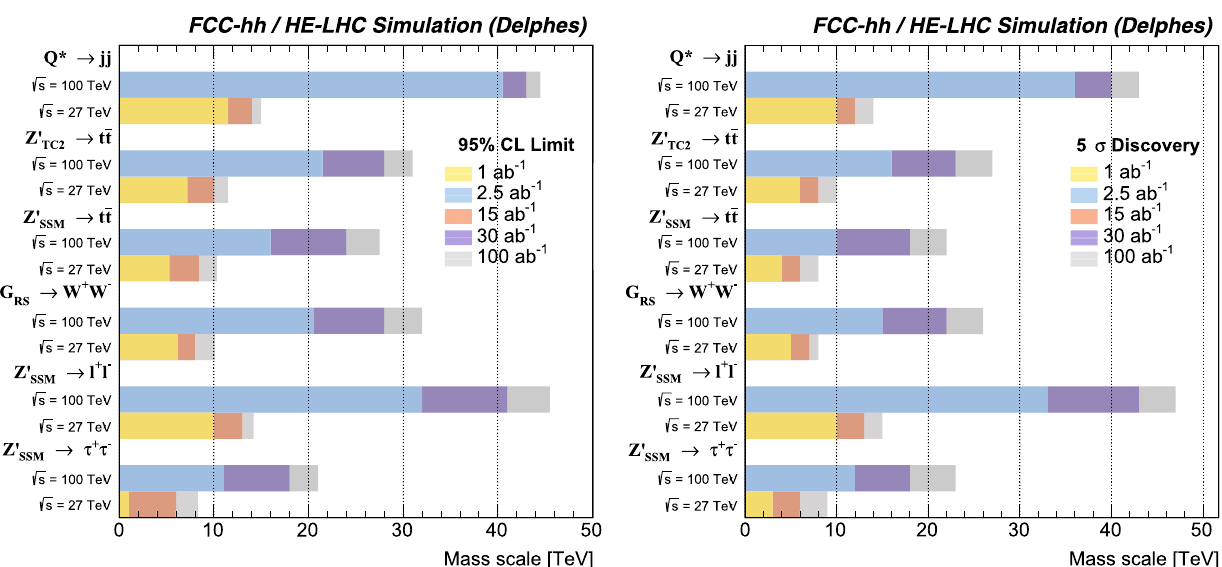
Fig. 10 Summary of the 95% CL limits (left) and 5 σ discovery reach (right) as a function of the resonance mass for different luminosity scenarios of FCC-hh and